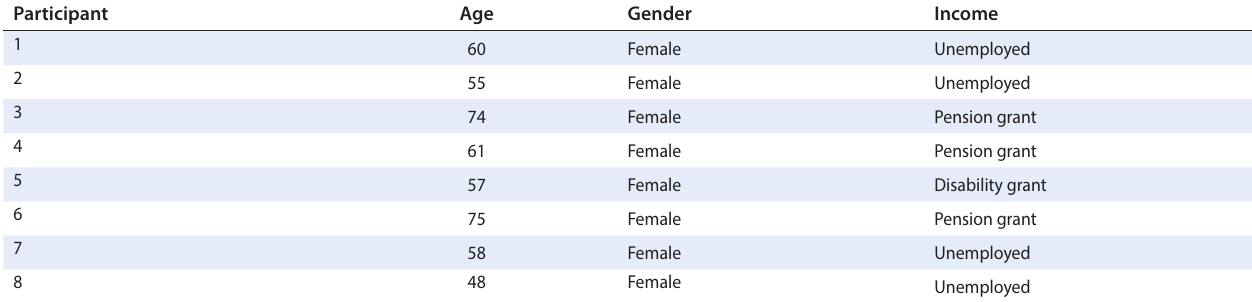
Table 2: Focus group interview 2